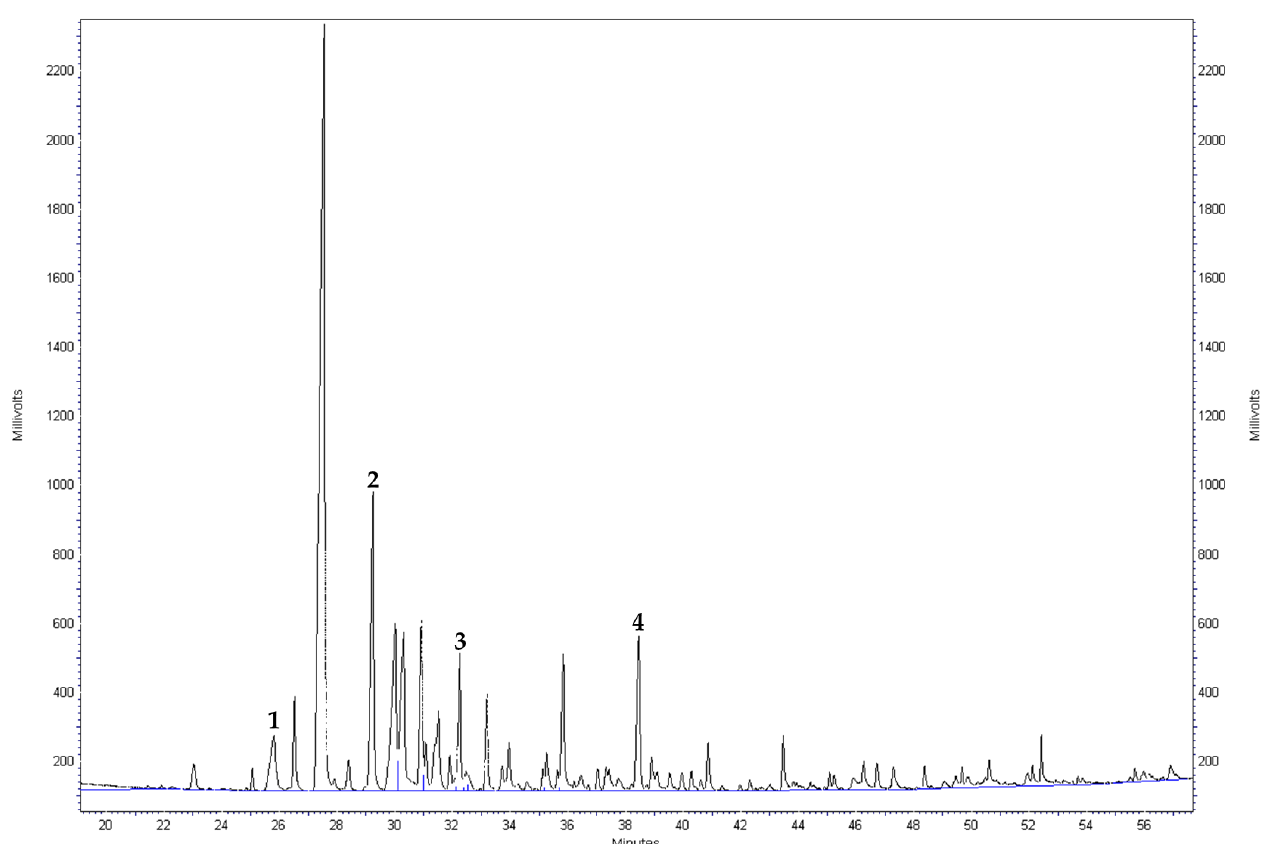
Figure A3. Chromatogram of sample of ripe Habanero pepper harvest from black soil and Maya- pan variety: (1) 1-hexanol, (2) hexyl-3-methyl butanoate, (3) 3,3-dimethyl-1-hexanol, and (4) cis-3- hexenyl hexanoate.